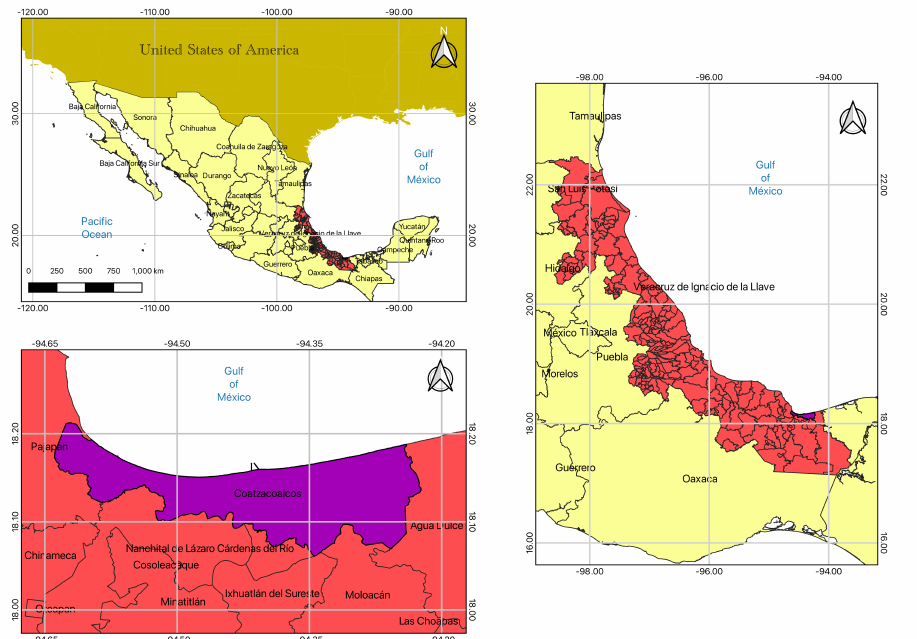
Figure 1. Location of Coatzacoalcos city in Veracruz, Mexico.